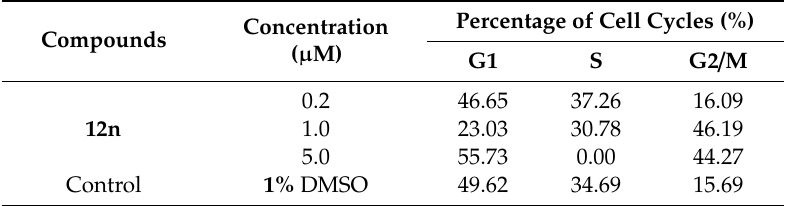
Table 5. Distribution of the cell cycle after treatment with 12n in PC-3